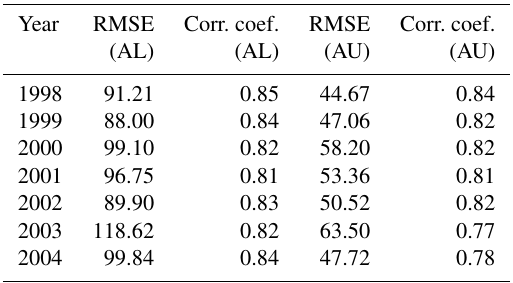
Table 1. The root mean square errors of the ESN prediction (in nT) and the Pearson correlation coefficients between the ESN prediction and the observation for the AL and AU indices. Year RMSE Corr.